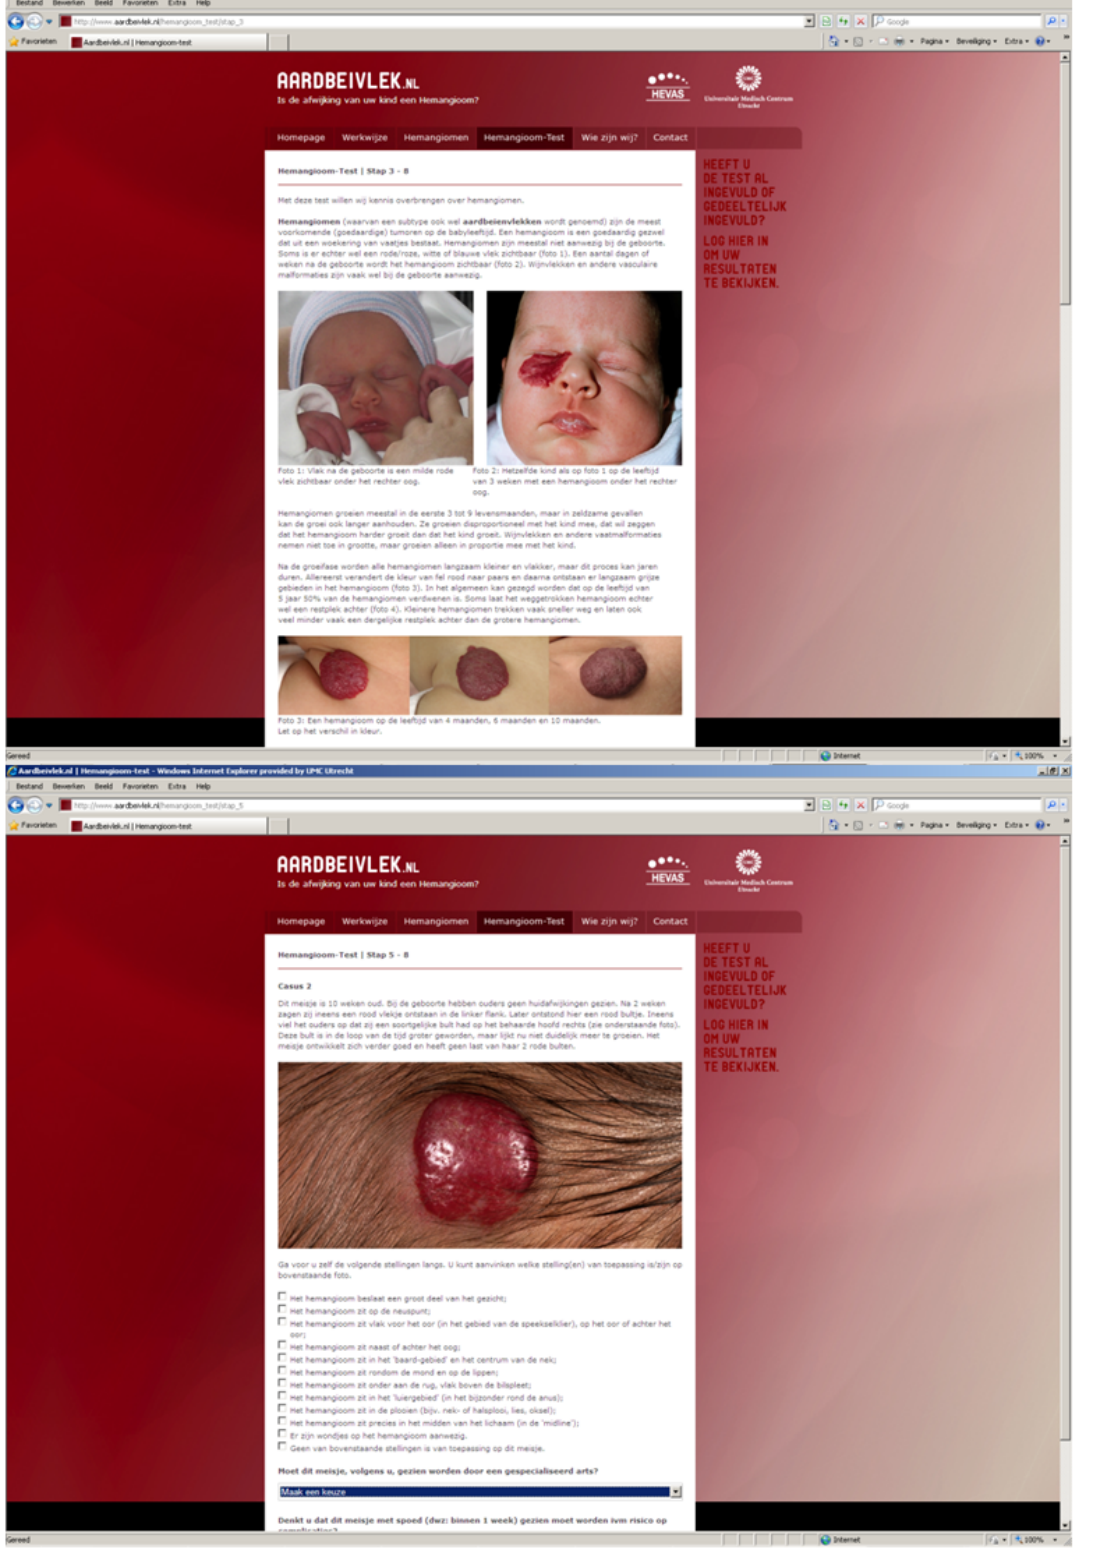
Figure 1. Illustrative screenshots of the e-learning module (in Dutch). The top image shows general information about infantile hemangiomas. The bottom image shows a case scenario of an infantile hemangioma on the scalp (Case